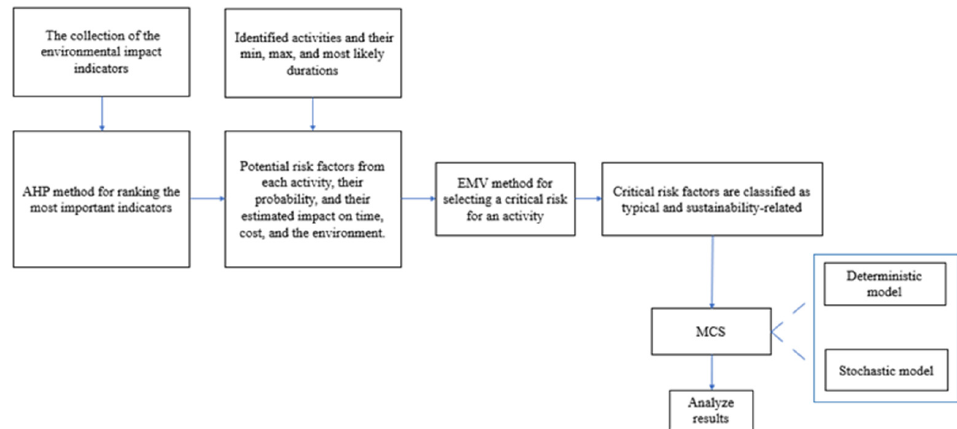
Figure 1. Flowchart of the Analysis Process.